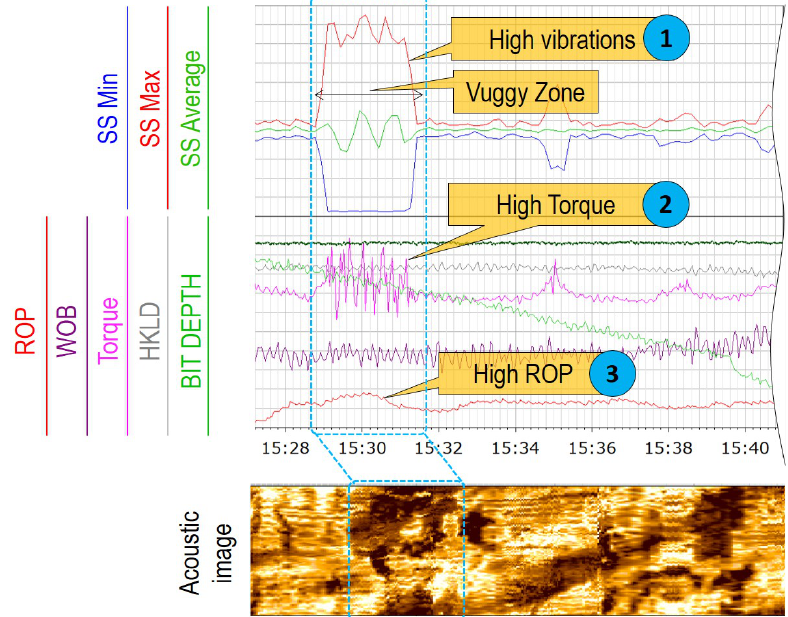
Figure 7. Drilling mechanics data in the interval of fracture and vugs (Well